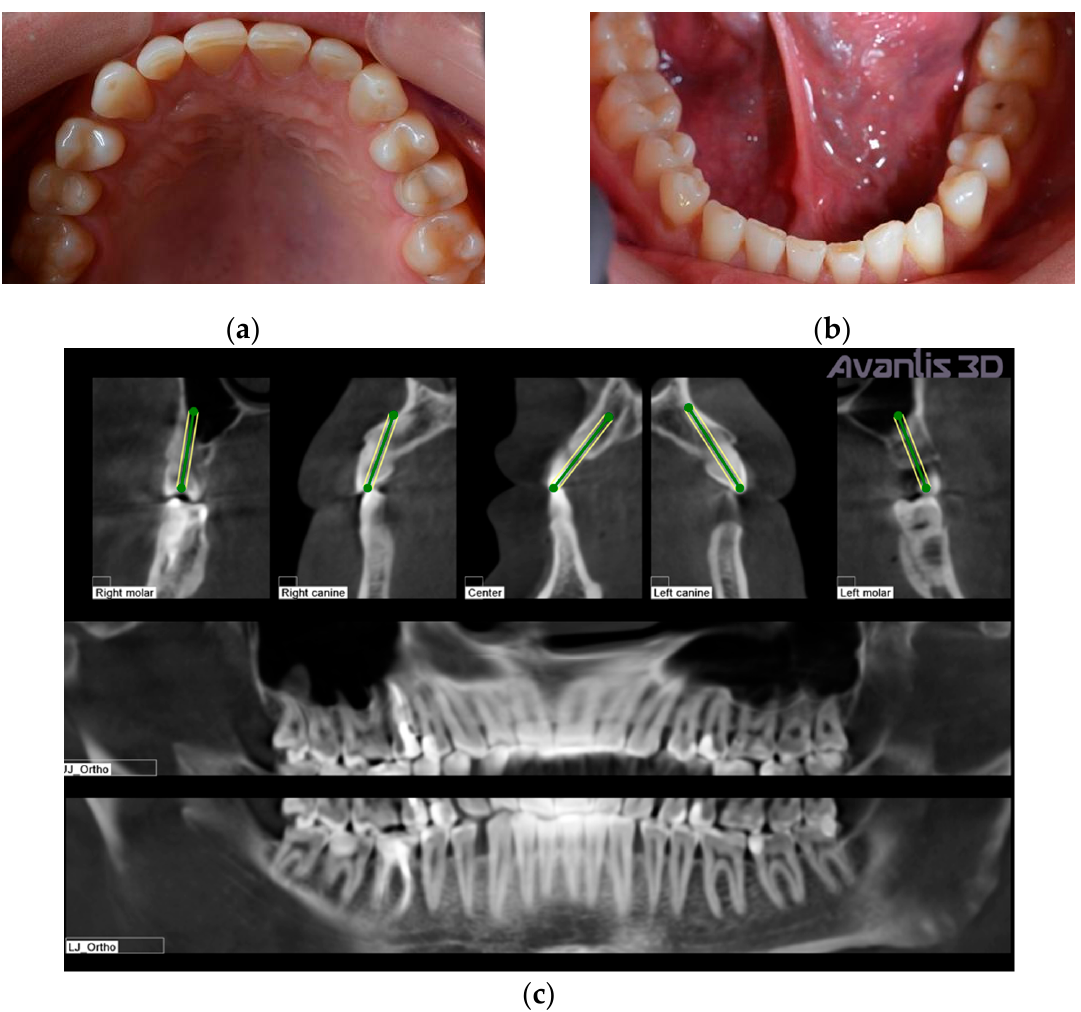
Figure 2. Intraoral occlusal views: ( a ) upper dental arch; ( b ) lower dental arch; ( c ) X-ray before treat- ment.